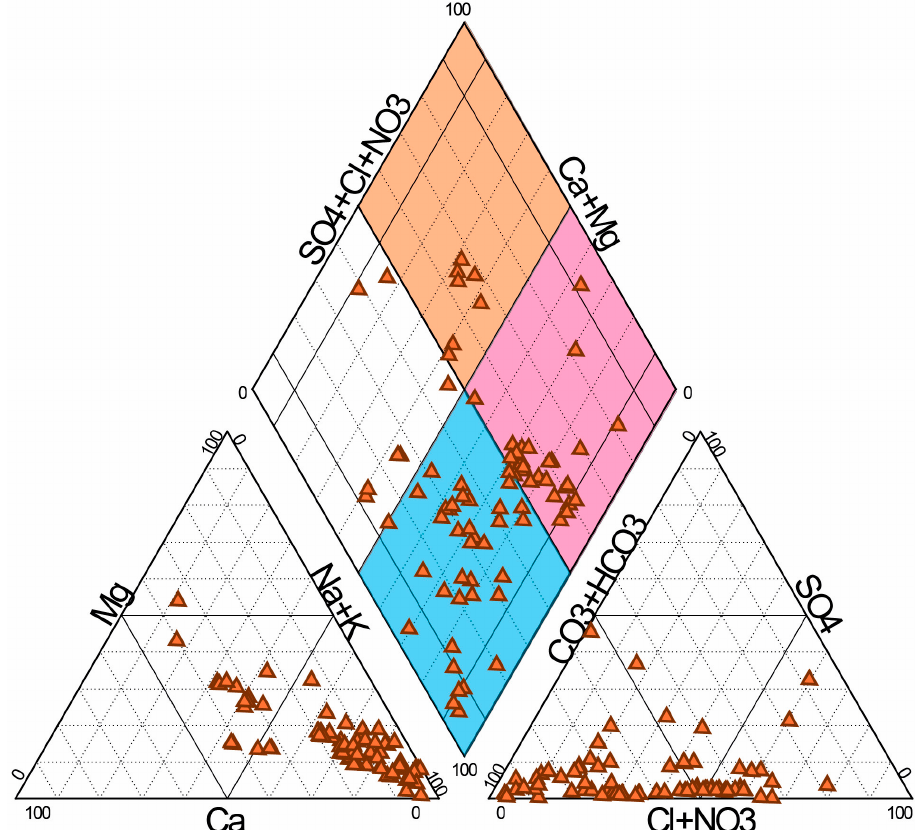
Figure 3. Piper diagram highlighting the main water types of the 79 mineral springs sampled. Several springs were bicarbonate-rich with sodium and potassium (blue diamond), others were characterized by chlorinated and sulphated calcium waters (orange diamond). At last, some mineral springs were characterized by sodium and potassium chloride or sodium sulphate waters (pink diamond).